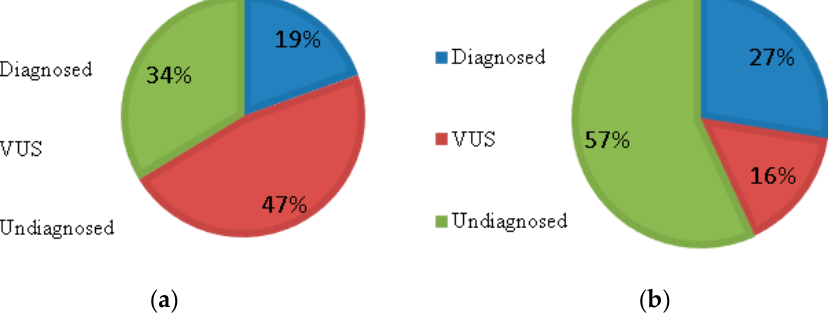
Figure 1. Efficiency of exome sequencing before ( a ) and after ( b ) segregation, tested by Sanger se ‐ quencing.